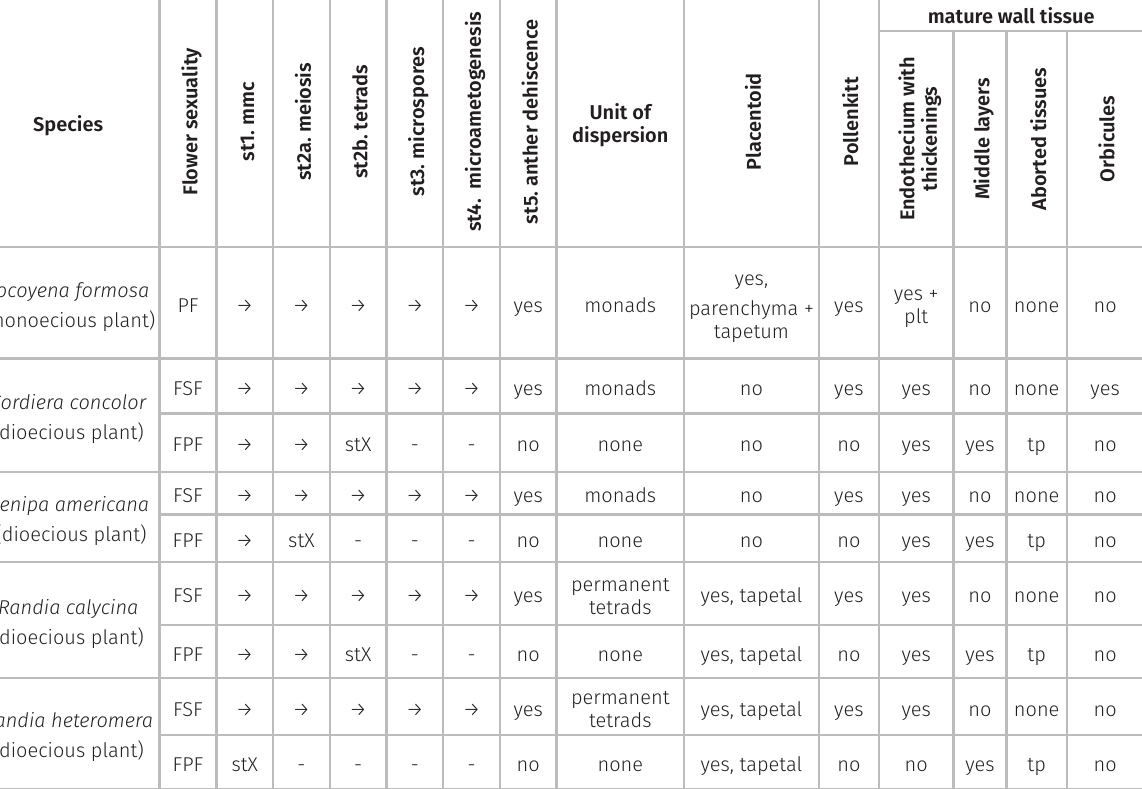
Table I. Summary of the anatomical characteristics of the androecium, stages of development and flower type of the study species of